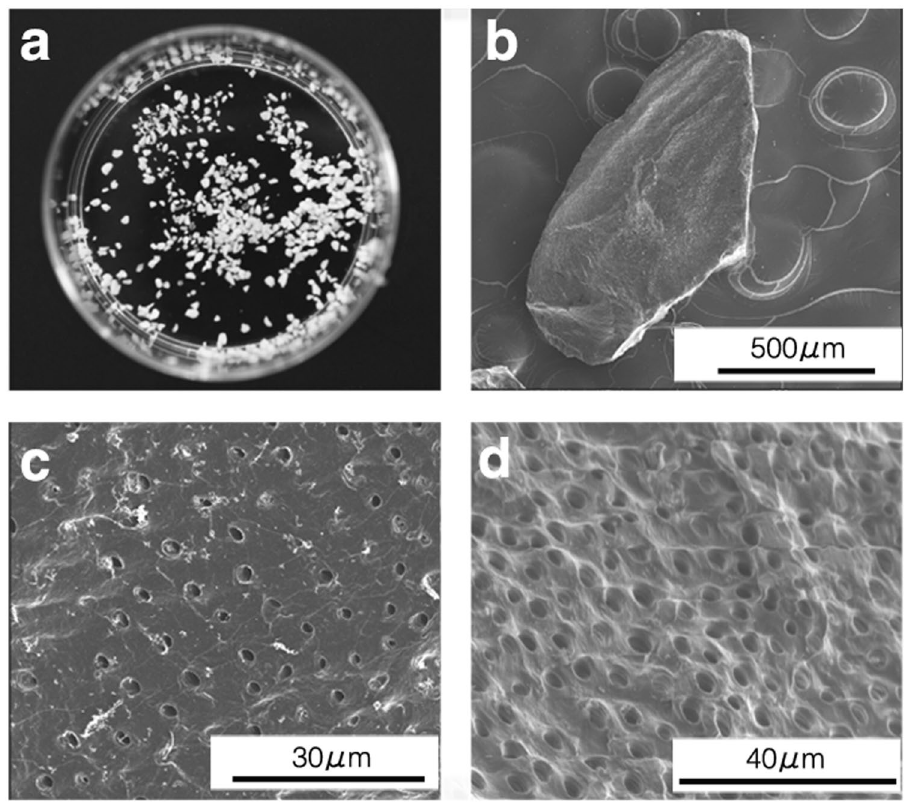
Figure 1. Scanning electron microscopy images of the demineralised dentin matrix (DDM). ( a ) Processed granules. ( b ) Higher magnification of image a. The surfaces of the DDM are lubricous ( c ) and rough ( d